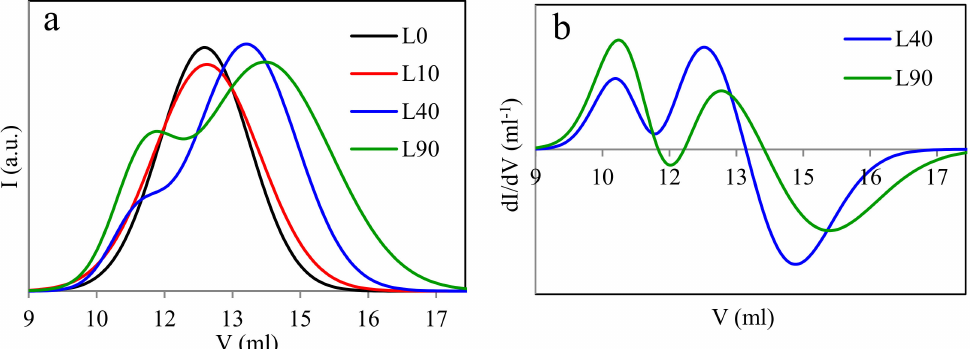
Figure 4. Results of the gel permeation chromatography (GPC) measurements for the samples with the predominant content of polylactide (PLA) ( a —GPC curves for the samples type L; b —derivatives ( dI / dV ) of the GPC curves for the samples L40 and